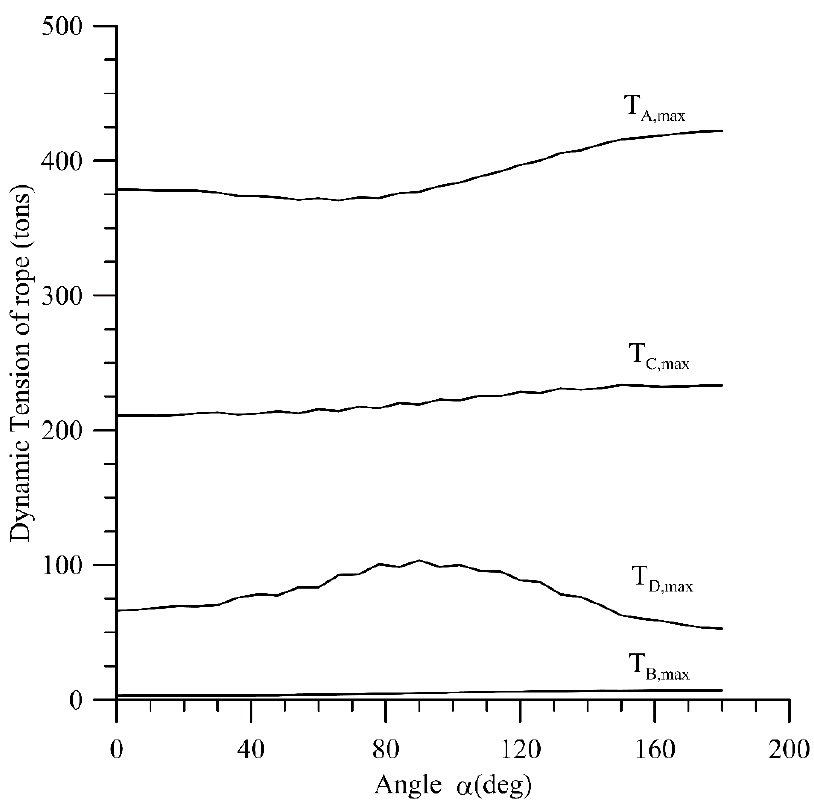
Figure 15. Dynamic tension of the four ropes under the typhoon irregular wave as a function of the relative angle α .